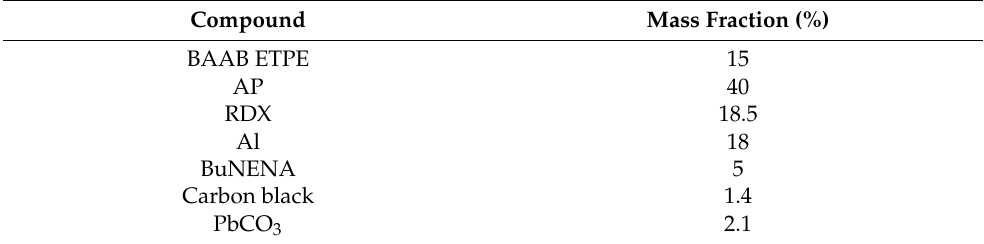
Table A2. Propellant formulation [39].